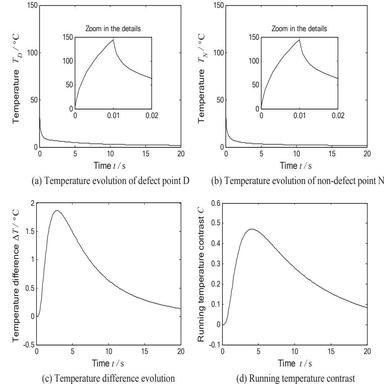
Defect signal evolutions (H = 10 mm, r = 5 mm, h = 2 mm).